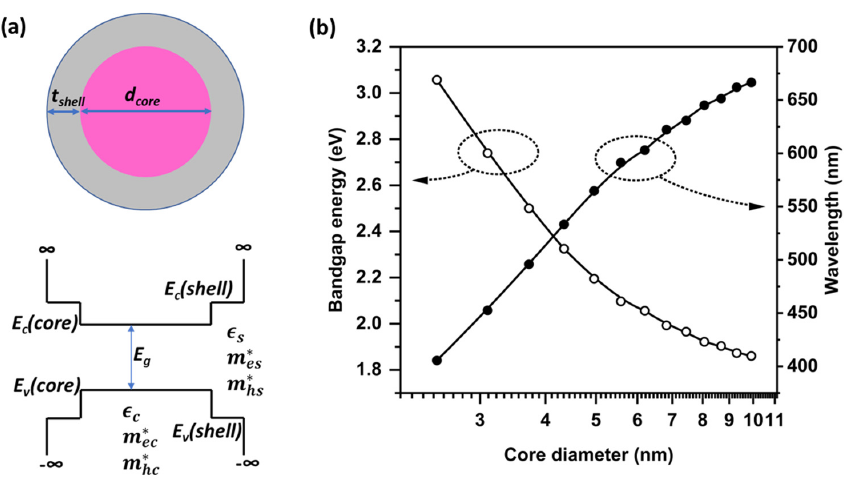
Figure 2. ( a ) Schematic diagram of a QD (top) and its potential profile (bottom), and ( b ) bandgap energy and wavelength as a function of the core diameter.